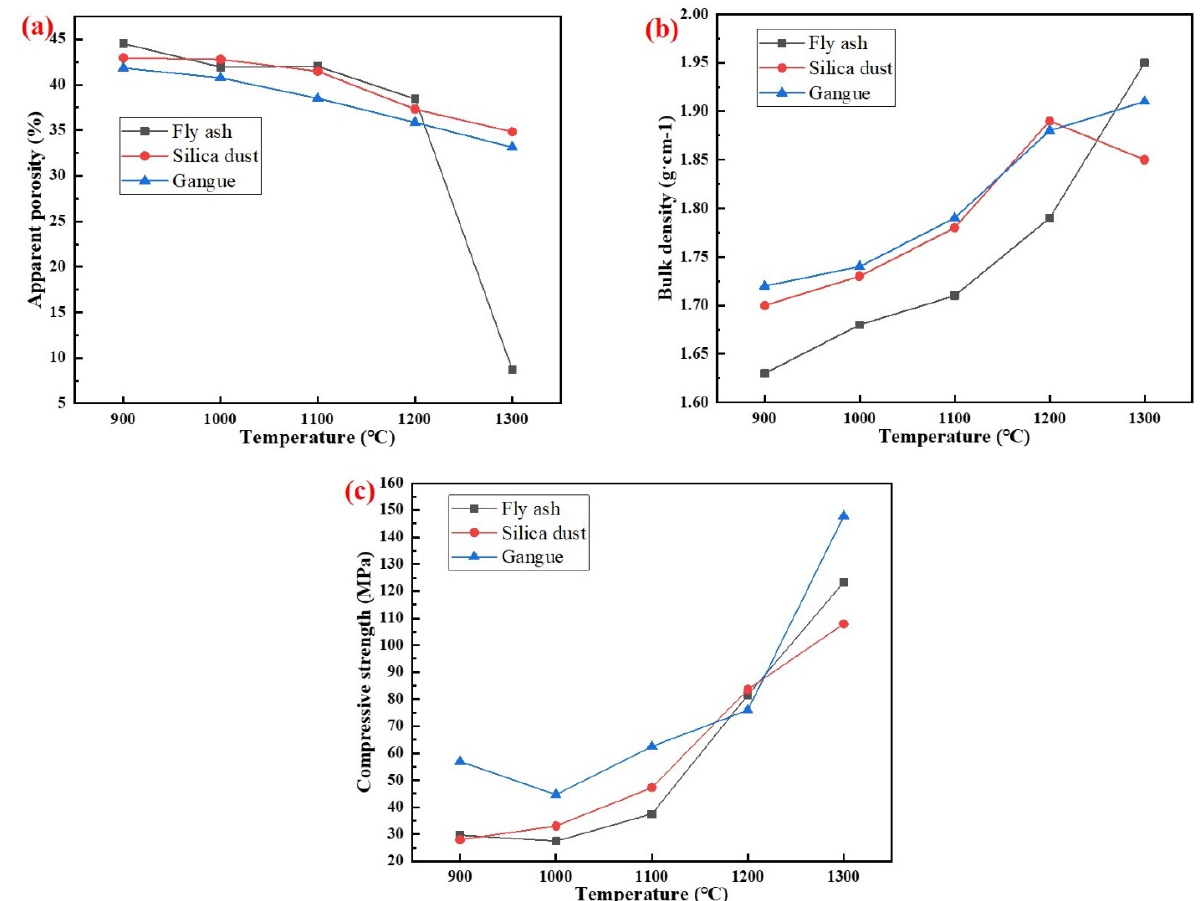
Figure 10. Physical properties of specimens with different silicon sources after sintering at 900–1300 °C for 2 h: ( a ) Fly ash; ( b ) Silica dust; ( c ) Gangue.